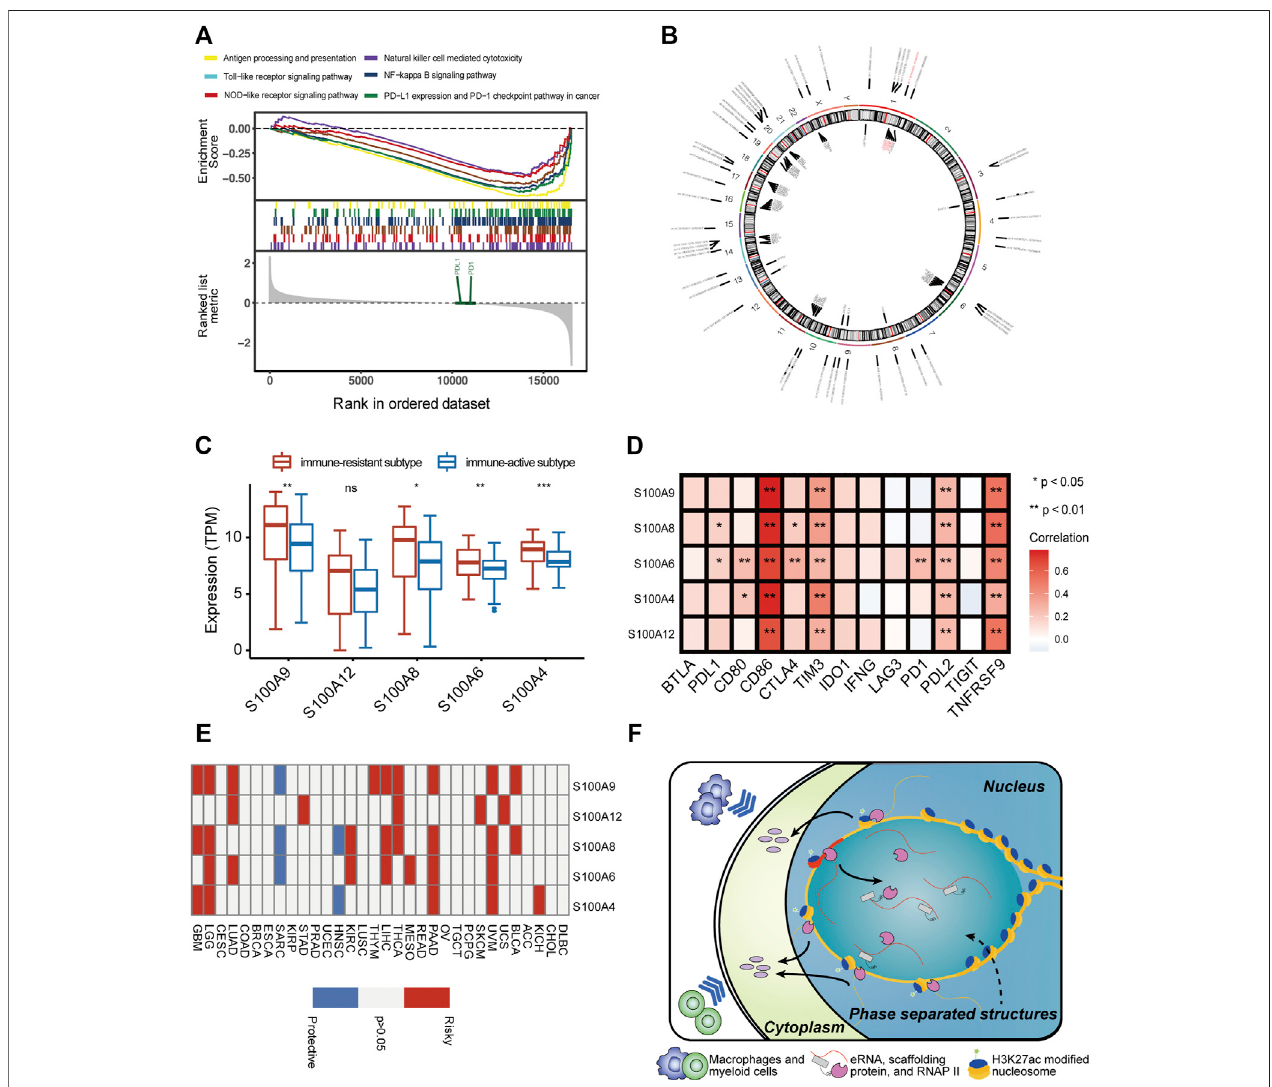
FIGURE 4 | S100-enhancer and S100-eRNA play a role in shaping the immunosuppressive microenvironment. (A) GSEA of immune-related pathways con fi rmed different pathway activation models between immune-resistant and immune-active subtypes. (B) The chromosomal locations of potential target genes of ir-eRNAs identi fi edinourstudy.RedoneswereS100-eRNAand fi veS100proteins. (C) HigherexpressionleveloftheninegenesregulatedbyS100-enhancerandS100-eRNAin the eRNA immune-resistant subtype compared with the immune-active subtype (ns, p > 0.05, * p < 0.05; ** p < 0.01; *** p < 0.001, Wilcoxon test). (D) Correlations betweenthe S100protein family and immunecheckpoint-related genes(Spearman correlation test, * p < 0.05;** p < 0.01). (E) Thesurvivalrelevance ofthe S100protein family in pan-cancers (red, risky factors; blue, protective factors; and grey, p > 0.05). (F) Schematic illustration of the putative mechanism by which S100-enhancer regulates immune in fi ltration. A phrase-separated structure is